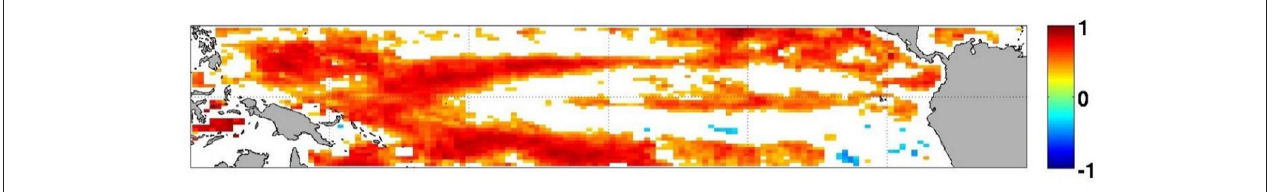
FIGURE 6 | Anomaly correlation coefficient between the forecasted chlorophyll at 1-month lead and S-NPP VIIRS chlorophyll for the period 2012–2015. White indicates that the correlation was not significant ( p > 0.05).